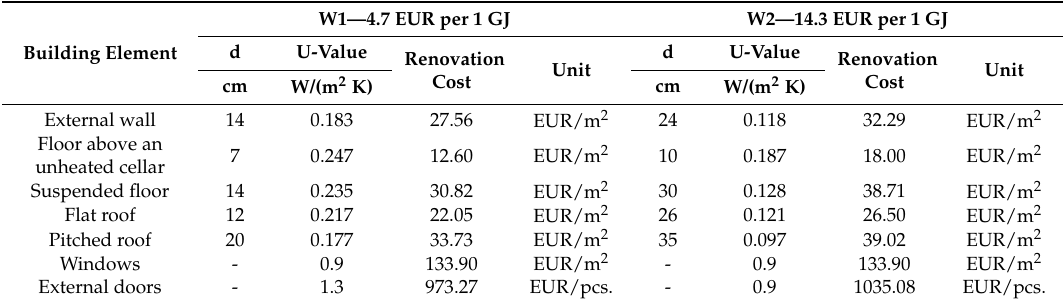
Table 13. The cost-optimum renovation variants (depending on the energy price) of building’s envelope—discount rate changed to 3%.